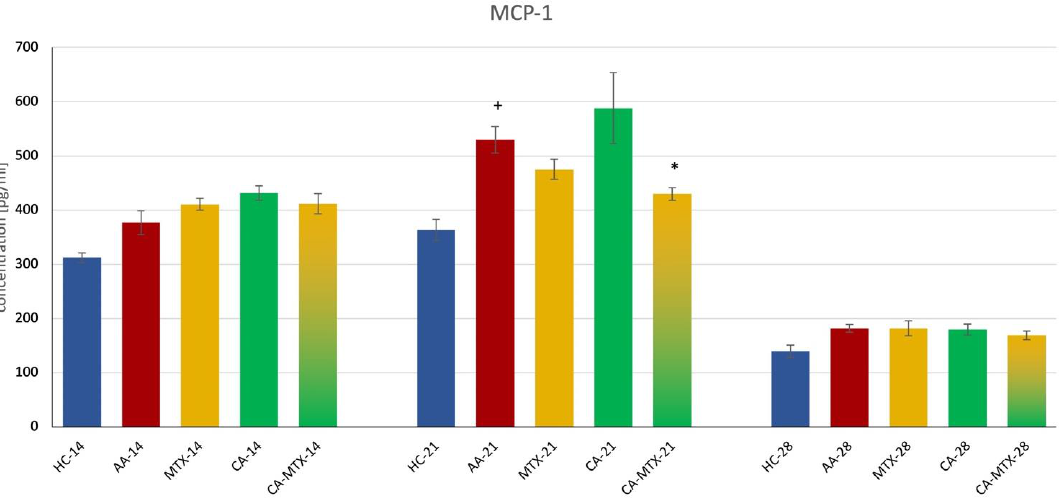
Figure 5. Monocyte chemotactic protein 1 (MCP-1) levels in plasma on the 14th, 21st, and 28th days. + HC vs. AA, * AA vs. MTX/CA/CA-MTX, p ≤ 0.05. + HC vs. AA, * AA vs. MTX/CA/CA-MTX, p ≤ 0.05.